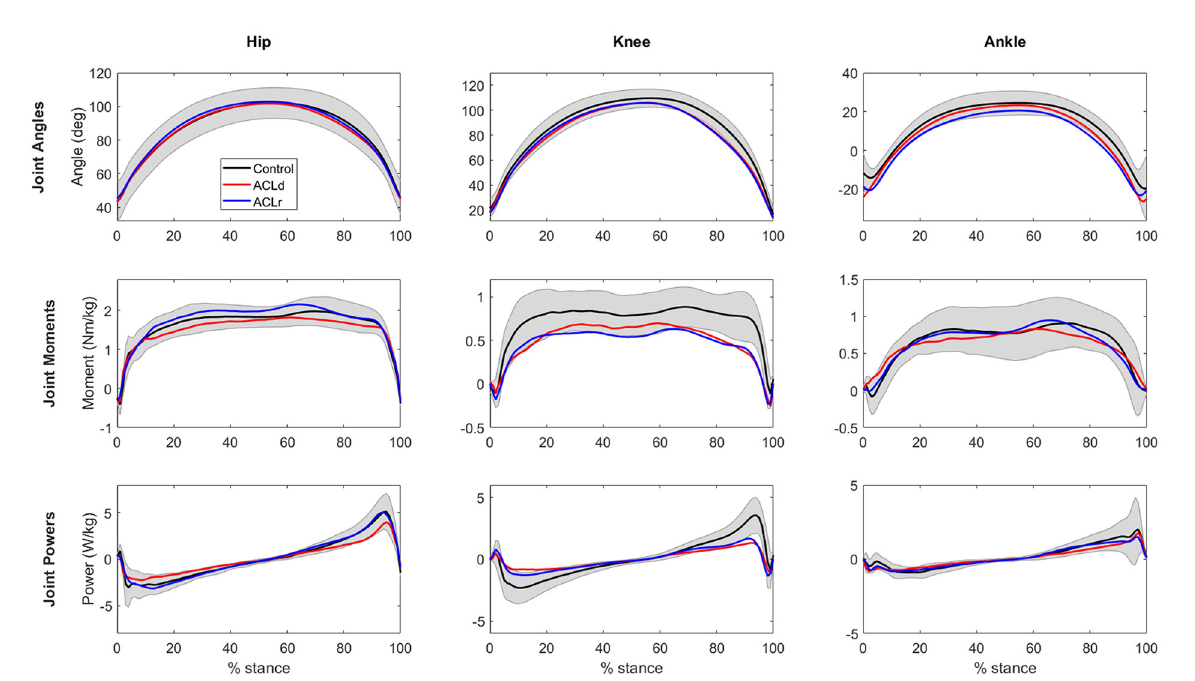
FIGURE4 Hip, knee and ankle joint sagittal plane angles and moments and joint power in the stance phase of the forward lunge. For statistical comparison between the groups refer to Table 2. The shaded are represents standard deviation for Control group. Standard deviations for the other groups are omitted for